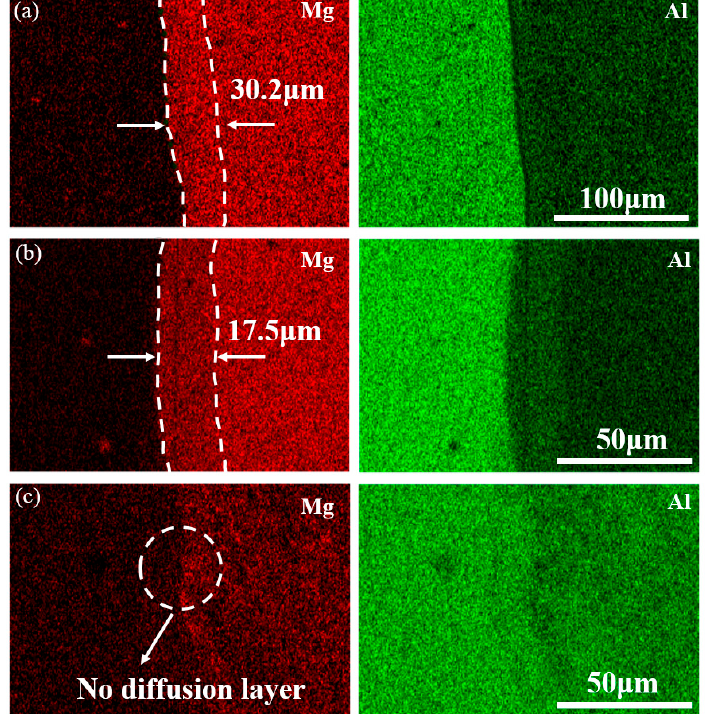
Figure 7. Energy-dispersive spectroscopy (EDS) maps of the 5A06 Al alloy interface: ( a – c ) represent the location E, F and G, respectively. Table 3. Chemical compositions (Weight Percent) measured by energy-dispersive spectroscopy (EDS) at Locations shown in Figure 6.